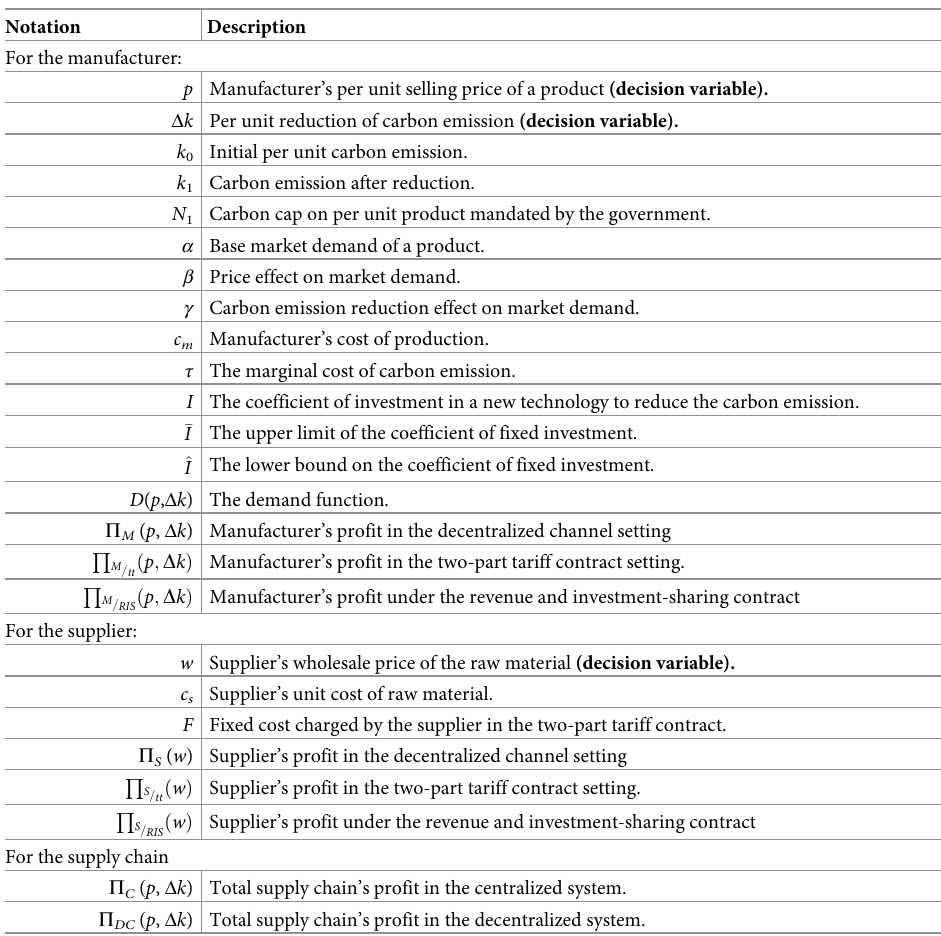
Table 2. Parameters and